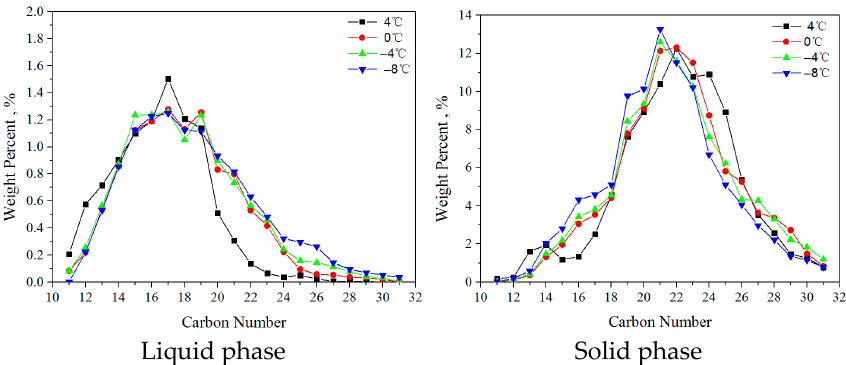
Figure 16. The normal paraffin distribution of liquid and solid phase at different temperatures.